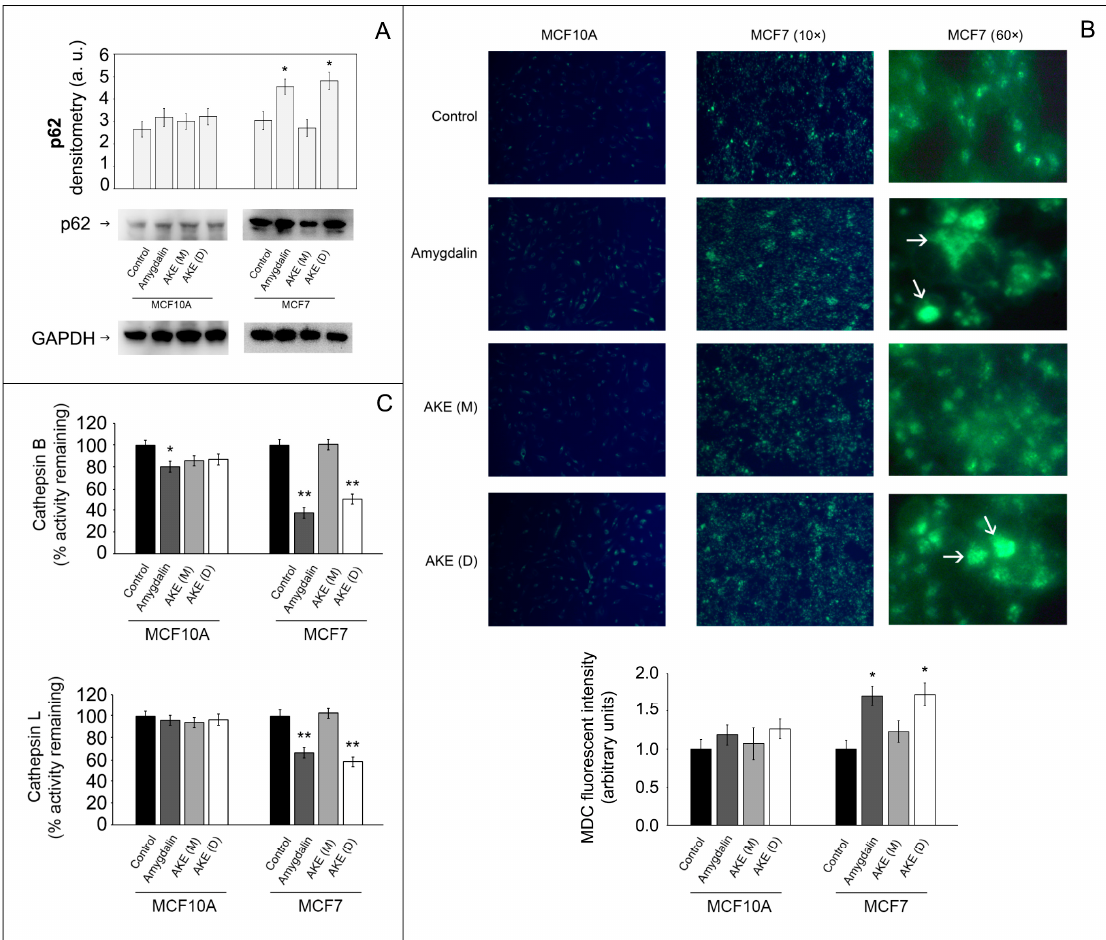
Figure 5. Effect of amygdalin and apricot kernel extracts on autophagy. ( A ) A representative Western blot of p62 protein and relative densitometry. GAPDH was used as equal loading control. Results are expressed as mean values and standard deviation and are obtained from five separate experiments. Statistical analysis was performed with one-way ANOVA, followed by the Bonferroni test using SigmaStat 3.1 software. * p < 0.05 indicates significantly different values compared with respective untreated control cells. ( B ) MDC staining of MCF10A and MCF7 treated cells. Cells were treated with amygdalin and kernel extracts and then exposed to the autofluorescent dye MDC to detect autophagic vacuoles. 10 × and 60 × magnifications are shown for MC7 cells. * p < 0.05 indicates significantly different values compared with respective untreated control cells. ( C ) Cathepsin B and cathepsin L activity measured in control and treated cells. Activity was measured using fluorogenic peptides as substrates as described in the Materials and Methods section. Data are indicated as percentage vs. untreated control cells (* p < 0.05, ** p < 0.01).